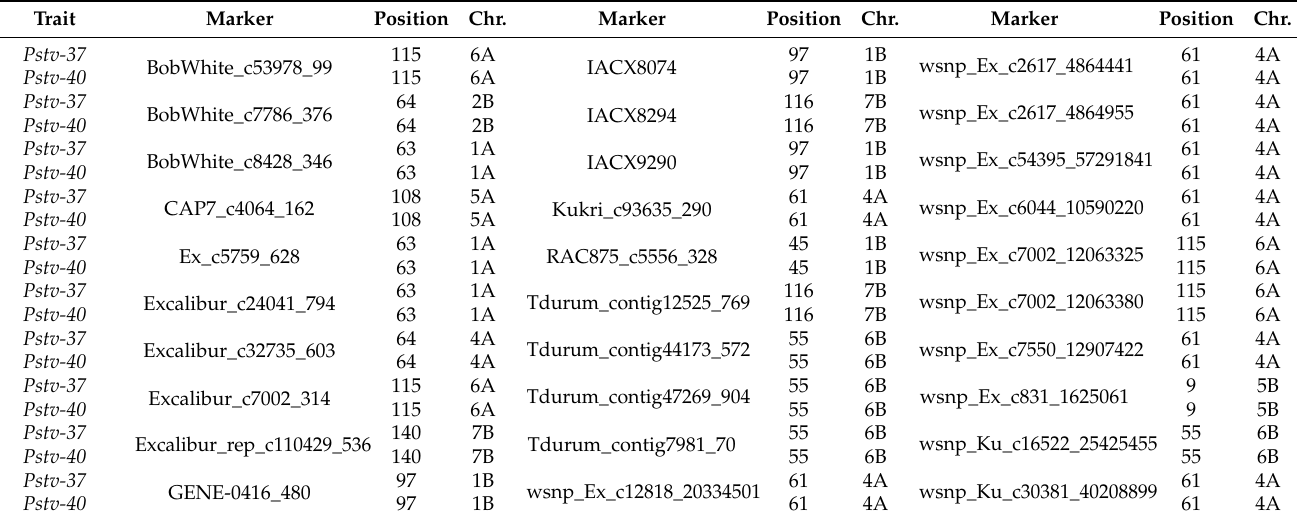
Table 3. List of SNP markers significantly associated with stripe rust resistance to both races Pstv-37 and Pstv-40 of Puccinia striiformis f. sp. tritici